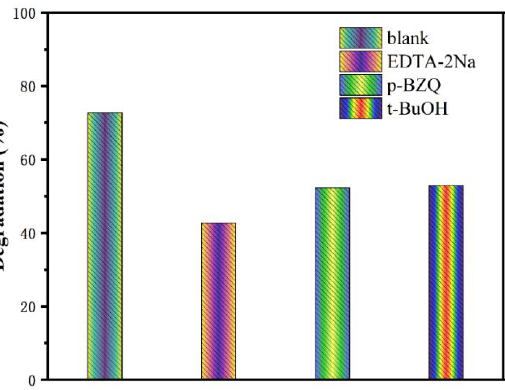
Figure 9. Active species capturing experiments for the degradation of 10 mg/L RhB over M53@PDI-20.